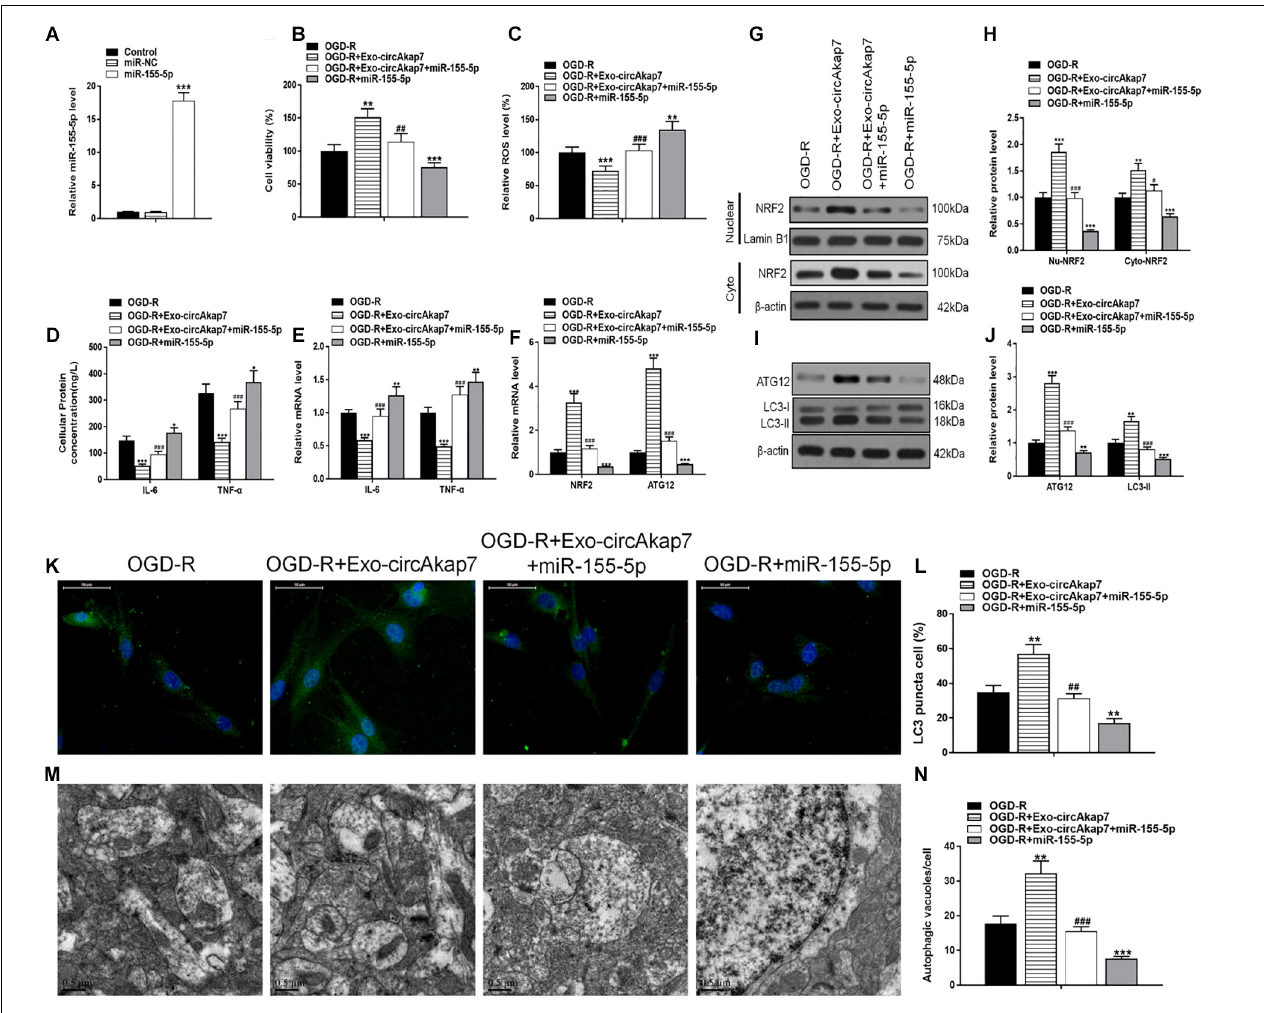
FIGURE 7 | Co-culture with exo-circAkap7 attenuates OGD-R-induced cellular injury by inhibiting miR-155-5p. (A) RT-PCR results displaying the level of miR-155-5p in astrocytes. Each experiment was repeated three times. (B) Cell viability as assessed by MTT assay. (C) Detection of cellular ROS levels. (D) ELISA results showing the expression of IL-6 and TNF- α in astrocytes. (E) RT-PCR results showing the levels of IL-6 and TNF- α in astrocytes. (F) RT-PCR results showing the levels of ATG12 and NRF2 in astrocytes. (G,H) The expression of cytosolic and nuclear NRF2 as analyzed by western blot and quantified. (I,J) The expression of ATG12 and LC3B as analyzed by western blot and quantified. (K,L) Representative photomicrographs and quantification of LC3B-positive puncta in cells. Nuclei were counterstained with DAPI (blue). (M,N) Autophagic vacuoles (autophagosomes) as detected by TEM. Representative TEM images, with typical autophagosomes marked with black arrows. The number of autophagosomes per cell was calculated by counting the number of double-membrane organelles in 10 cells. Data are expressed as the mean ± SEM, each experiment was repeated six times. * p < 0.05, ** p < 0.01, *** p < 0.001 vs. OGD-R, # p < 0.05, ## p < 0.01, ### p < 0.001 vs.